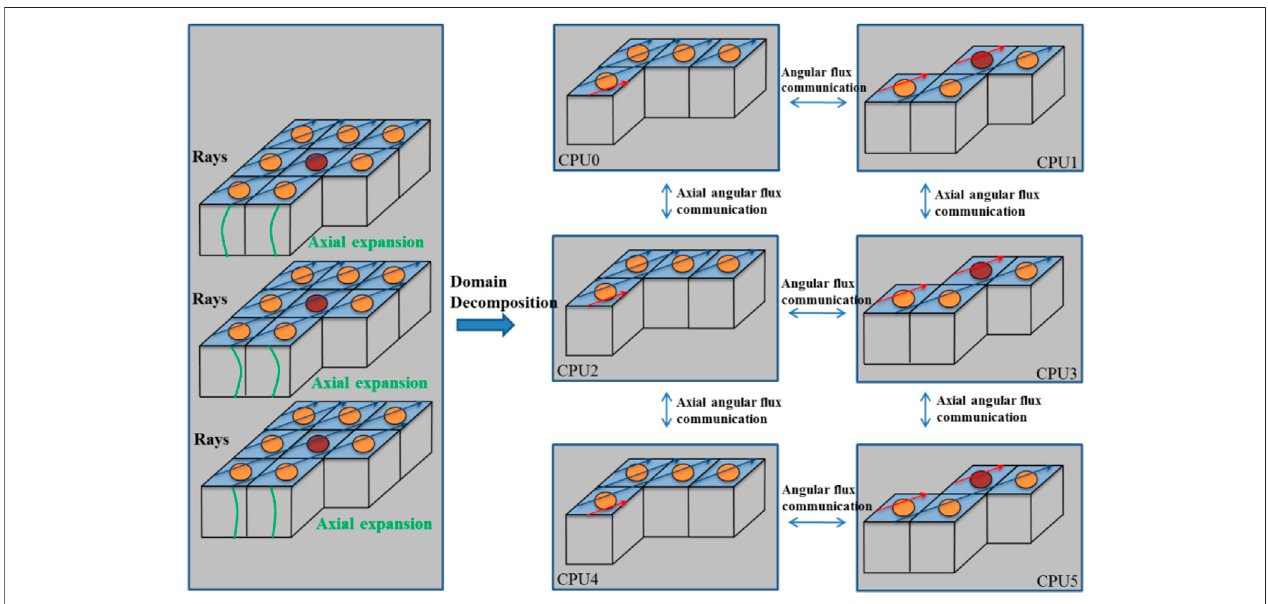
FIGURE 5 | The diagram of domain decomposition in SHARK.